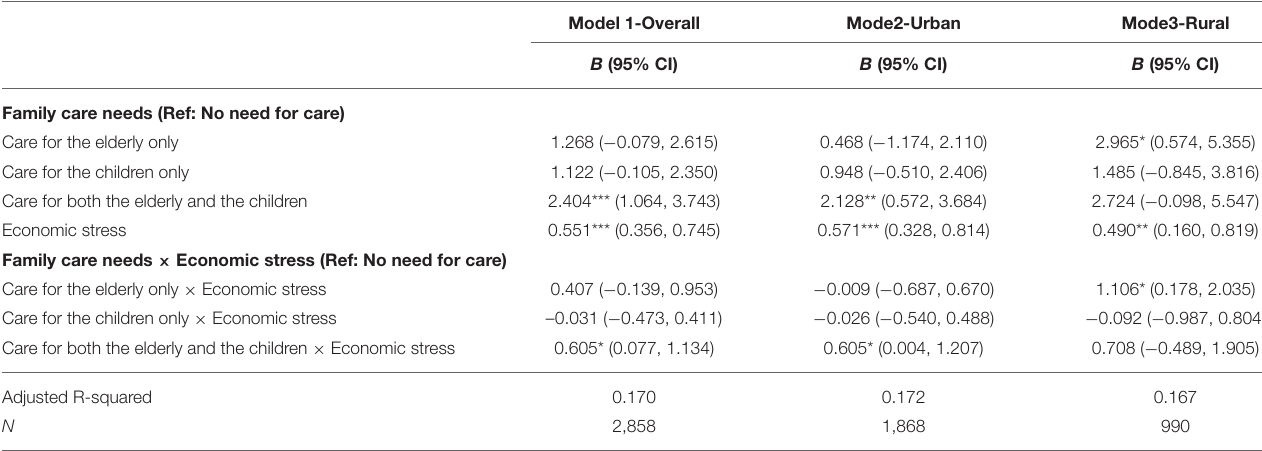
TABLE 4 | Multiple liner regression analysis of the interaction effect of family care needs and economic stress on depressive symptoms.